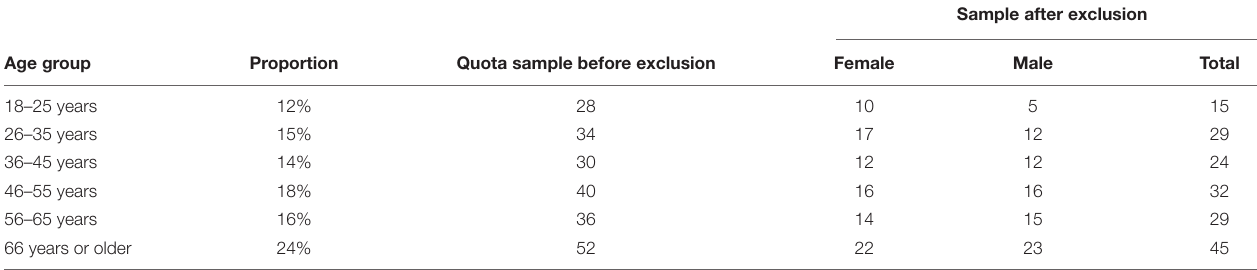
Sample after exclusion